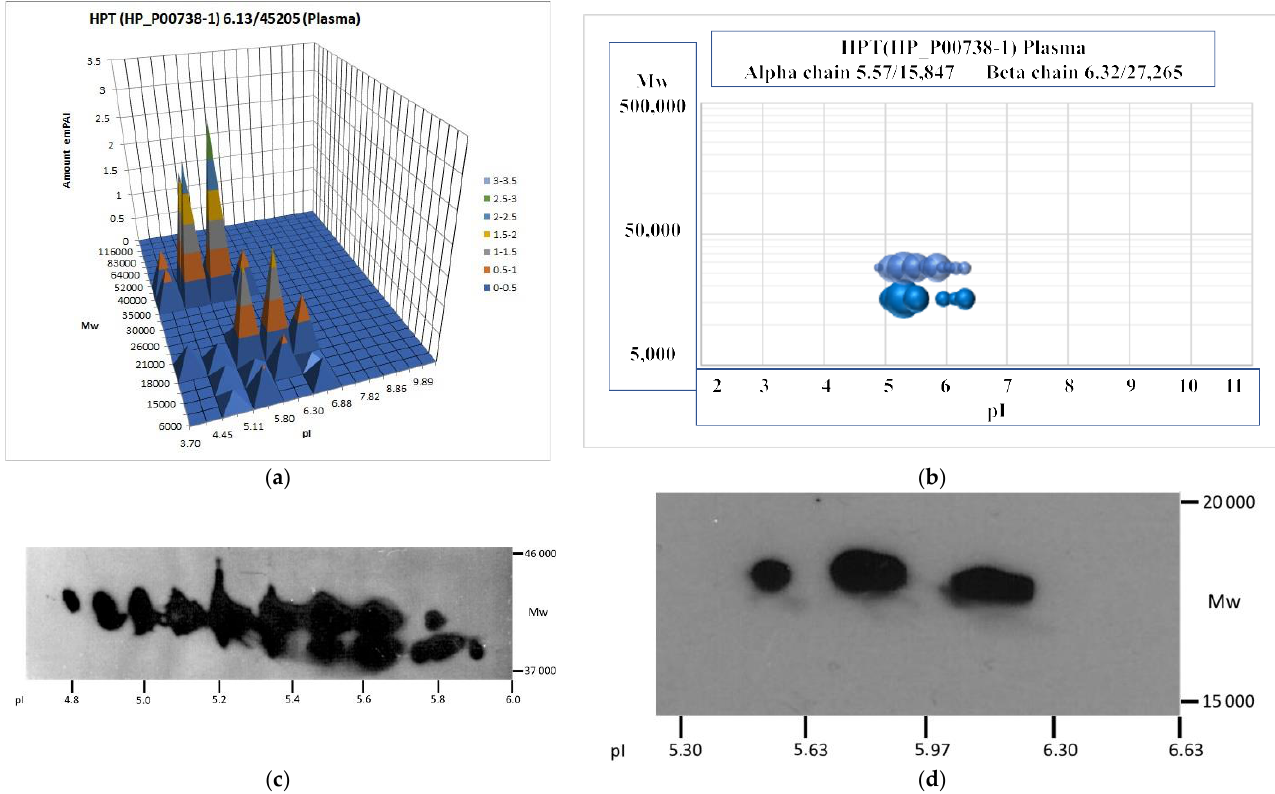
Figure 2. Two-dimensional electrophoresis patterns of haptoglobin alpha and beta chains. ( a ) A sectional analysis of alpha and beta chains. The stained gel was divided into the sections with the predetermined coordinates. Then each section was treated and analyzed by LC ESI-MS/MS (see Materials and Methods, Section 4.2, 2DE). According to the abundance (emPAI) of Hpt in each section, the graph was plotted. ( b ) A semi-virtual 2DE of alpha and beta chains (see Materials and Methods, Section 4.2, 2DE). According to the emPAI of alpha chain (theoretical Mw: 15,946) or beta chain (theoretical Mw: 27,265) in the sections, the graph was plotted. The ball size is proportional to emPAI in each section. ( c ) Two-dimensional electrophoresis – Western of beta chain. ( d ) Two-dimensional electrophoresis – Western of alpha2 chain.